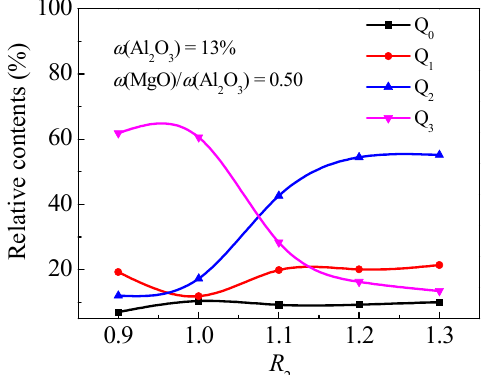
Figure 4. Relative content curves of Q n with the various R 2 .